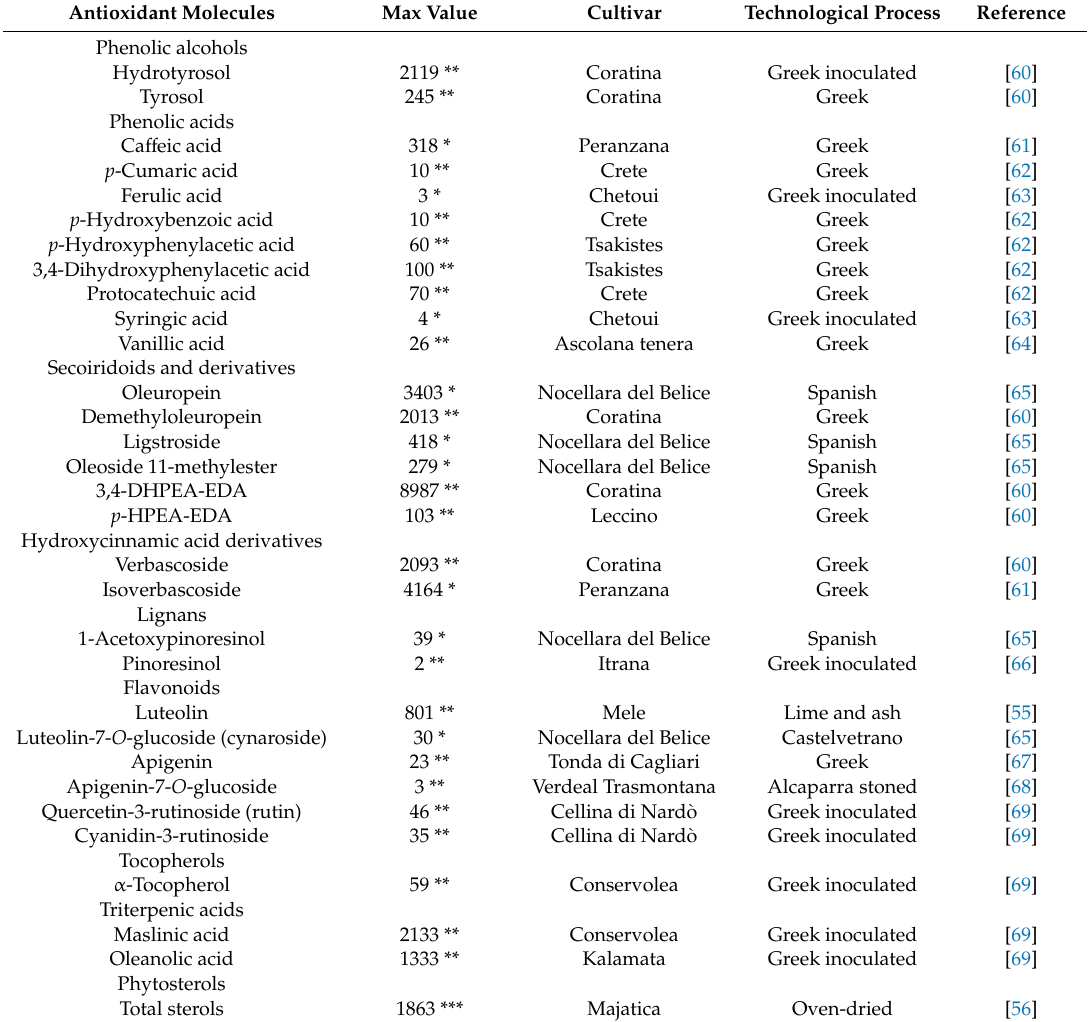
Table 2. Maximum values of antioxidant molecules in table olives (TOs) related to cultivar and